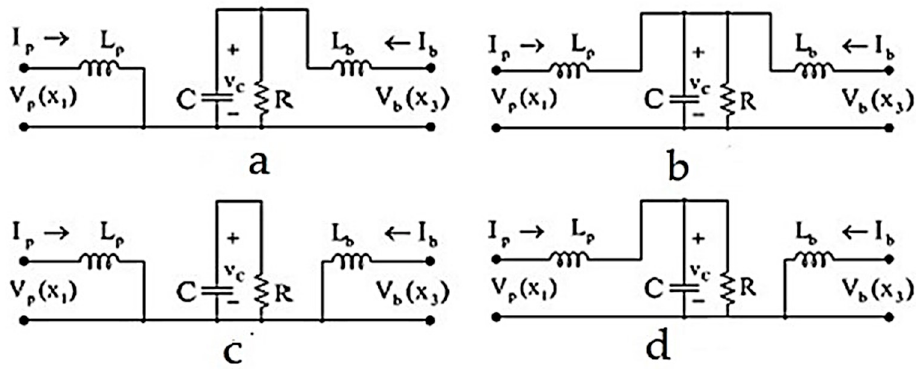
Figure 2. Operating modes of switching circuit. ( a ) SW1: closed, SW2: closed, and SW3: open. ( b ) SW1: open, SW2: closed, and SW3: open. ( c ) SW1: closed, SW2: open, and SW3: closed. ( d ) SW1: open, SW2: open, and SW3: closed.